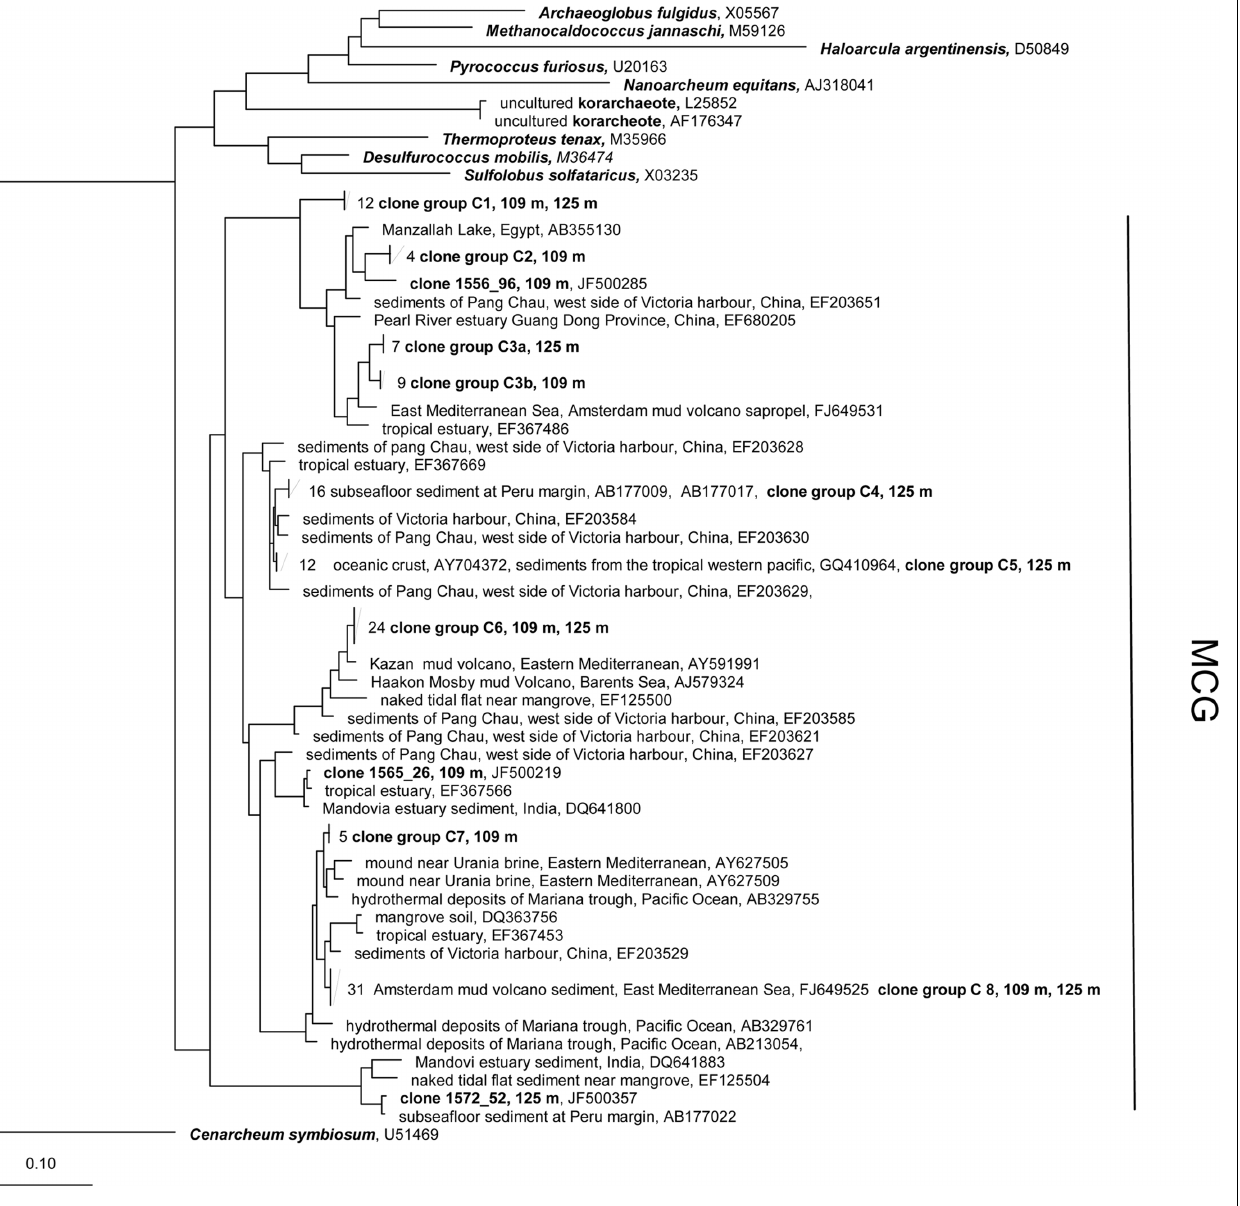
was rooted with Cenarchaeum symbiosum as a representative of the deeply branched group “ Thaumarcheota .” MCG, Miscellaneous Crenarcheotic Group.